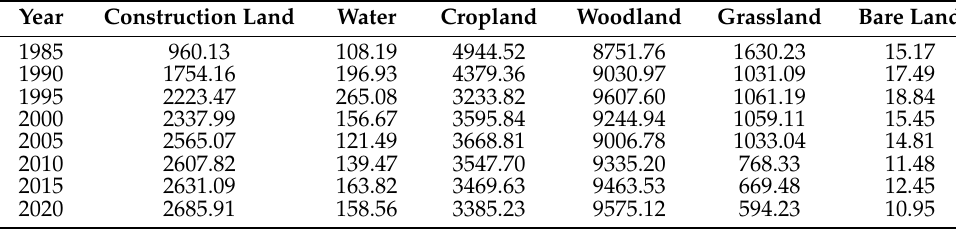
Figure 3. LULC maps from 1985 to 2020 in Beijing. Table 3. The land use pattern changes from 1985 to 2020 in Beijing (km 2 ).